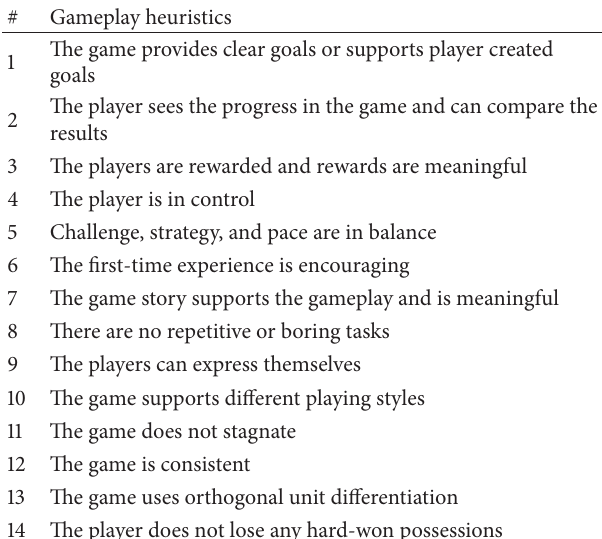
Table 6: Heuristics for evaluating gameplay.